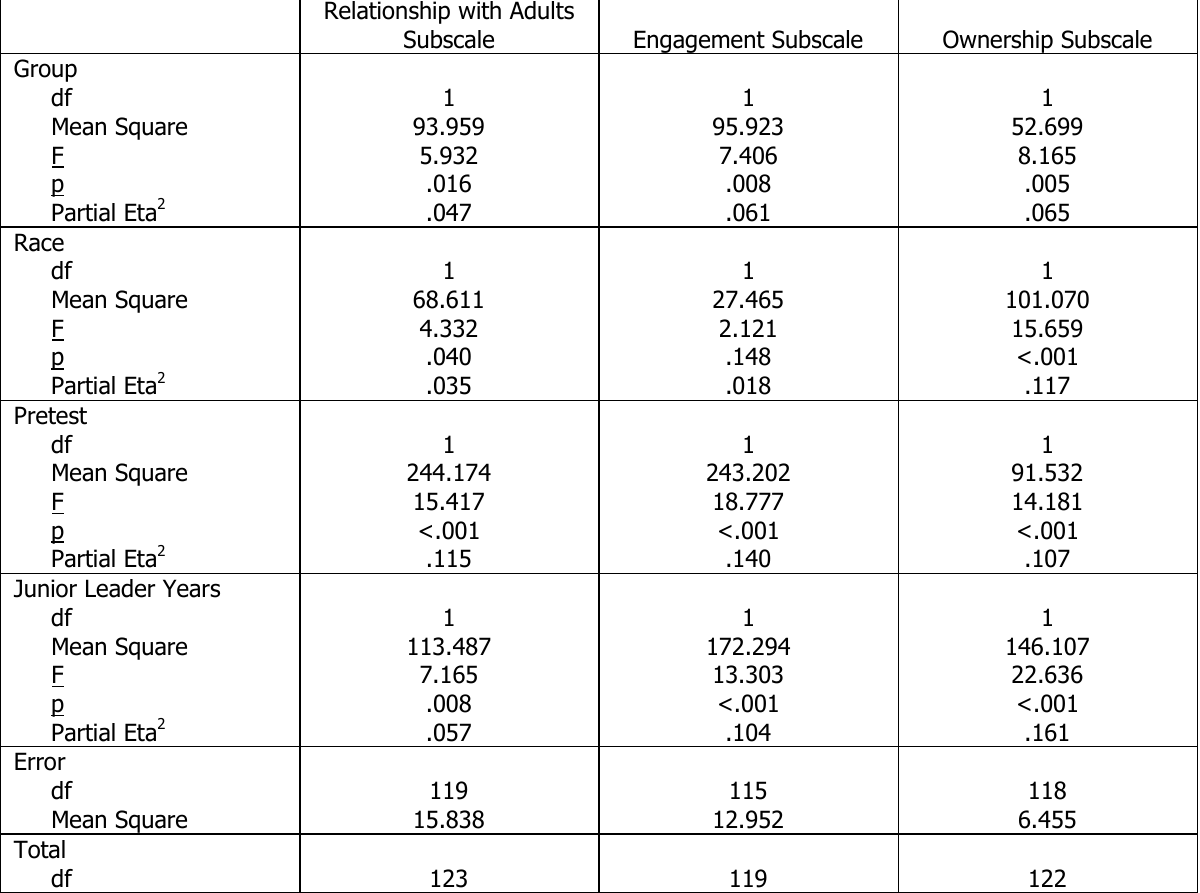
Analysis of Covariance of POST Measurements of Perception of Youth Voice Using Subscale Summated Scores Controlling for PRE Measurements of Perceptions of Youth Voice Using Subscale Summated Scores and for Number of Years in Junior Leader Club Relationship with Adults Subscale Engagement Subscale Ownership